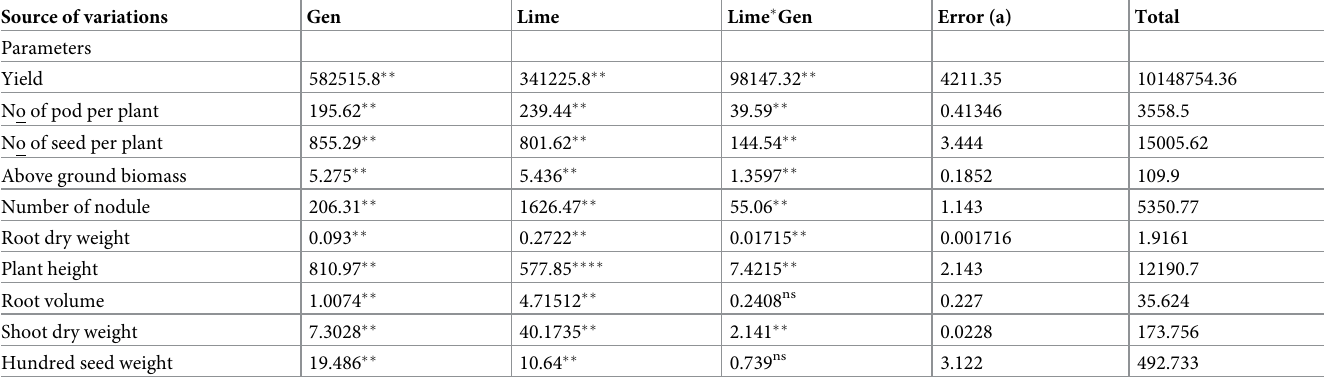
Table 3. Mean square of growth, root, nodulation, yield and yield components of soybean genotypes grown on limed and unlimed soil on field. Source of variations